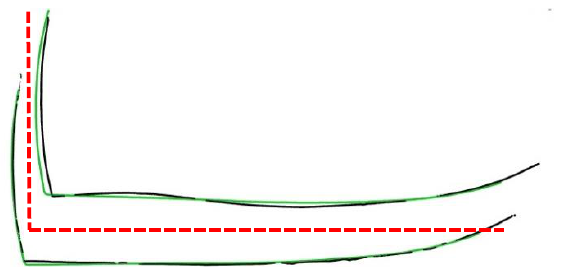
Figure 10: Uncorrected dataset vs. reference (top right) and corrected dataset vs. reference (bottom